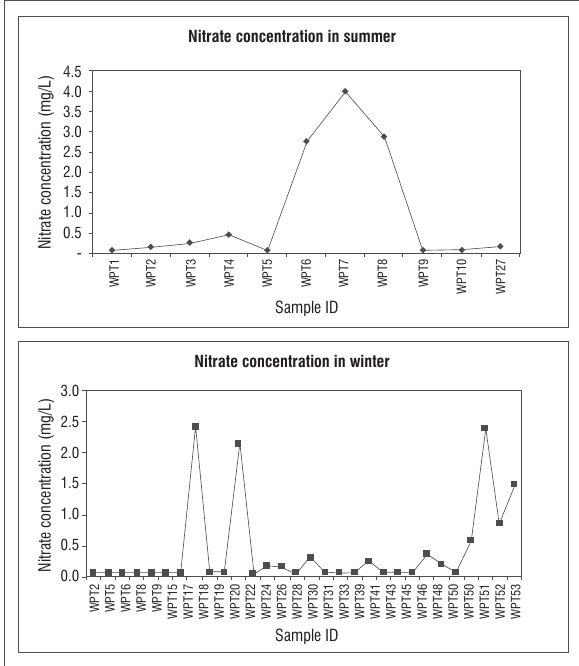
Figure 4: Seasonal variation of nitrate concentration in Bonsma Dam.